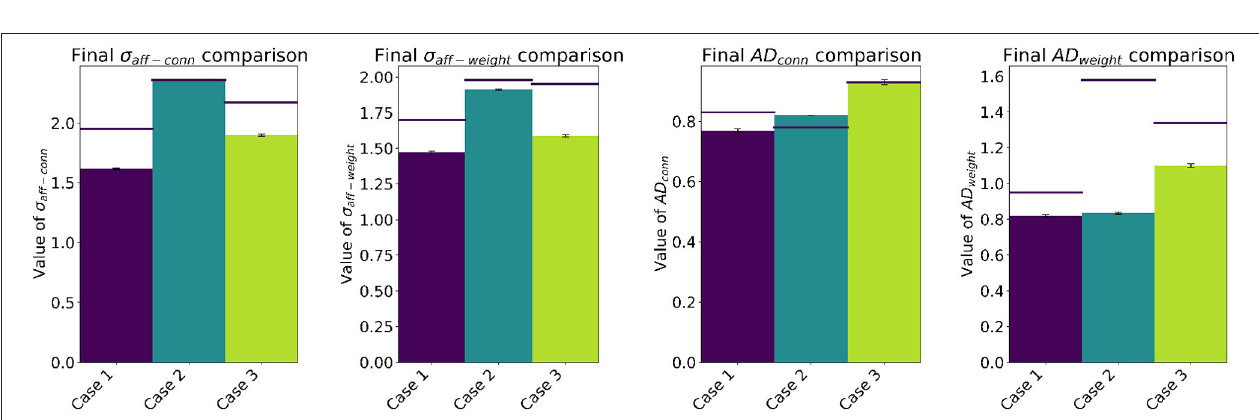
FIGURE 4 | Final values of σ aff − conn , σ aff − weight , AD conn and AD weight , including standard error of the mean computed from values obtained over 10 experiments. Horizontal lines show single-trial results from Bamford et al. (2010).